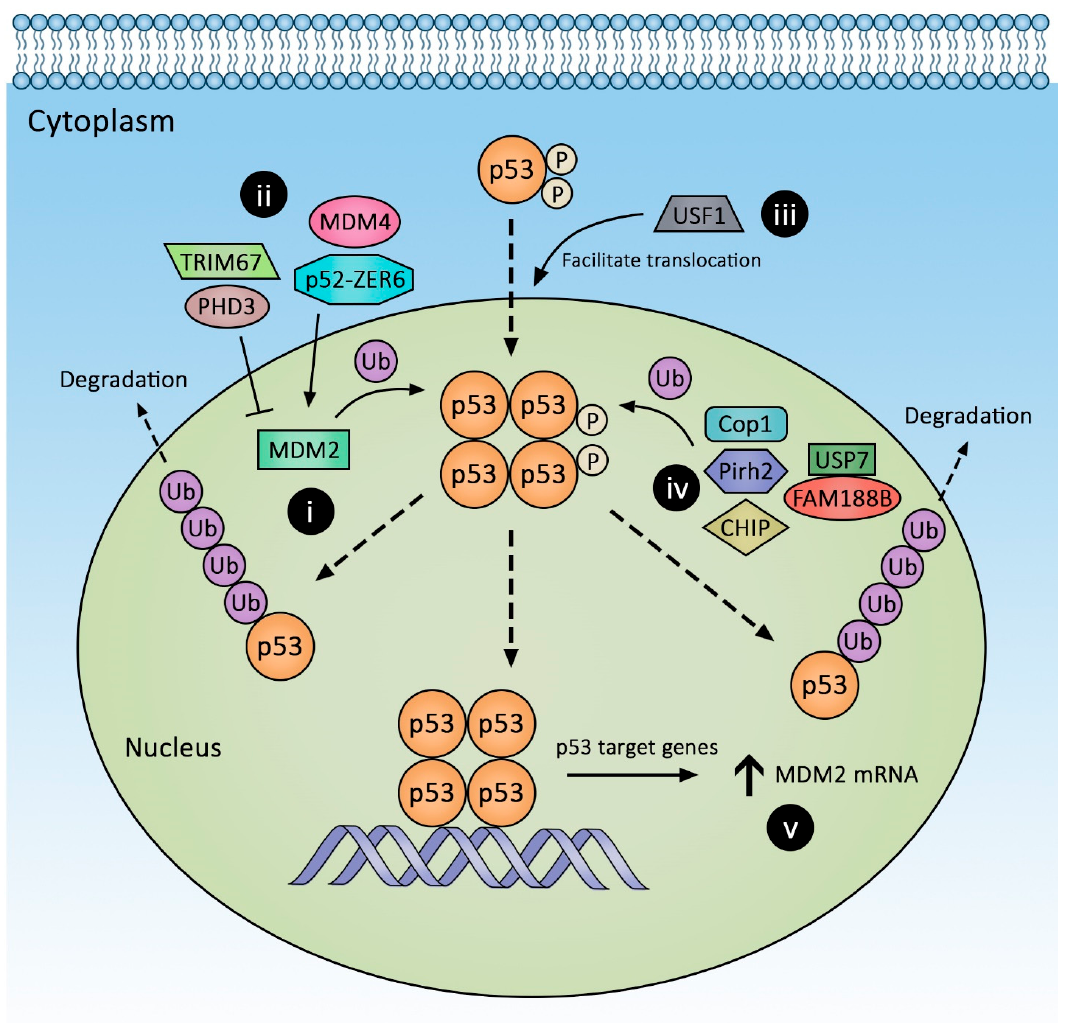
Figure 1. Key molecules involved in post-translational regulation of wild-type p53. Post translational regulation of p53 involves several distinct mechanisms, including (i) direct interaction with mouse double minute 2 homolog (MDM2), which stimulates proteasomal degradation; (ii) PHD3, TRIM67, MDM4, and ZER-p52 modulate MDM2 function; (iii) USF1 facilitates translocation of the MDM2/p53 complex into the cytoplasm for degradation; (iv) MDM2-independent p53 degradation via CHIP, Pirh2, COP1, and the USP7-FAM188B complex; and (v) MDM2 transcriptional upregulation by